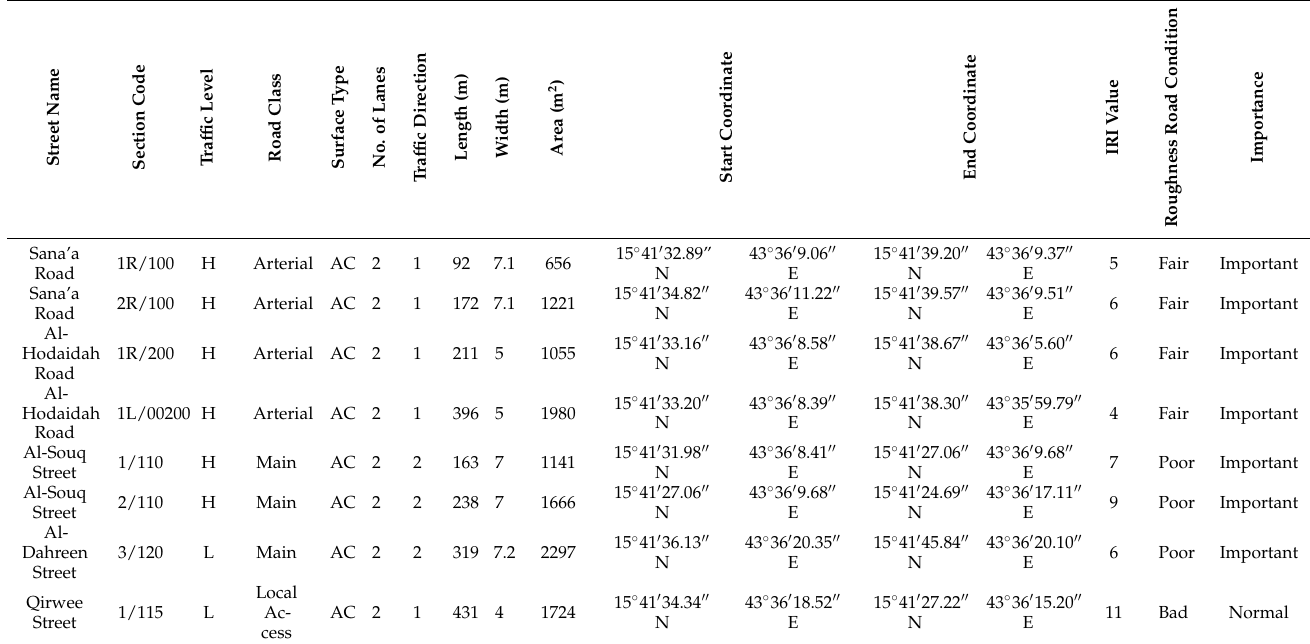
Table 1. Sample of road segment condition data.